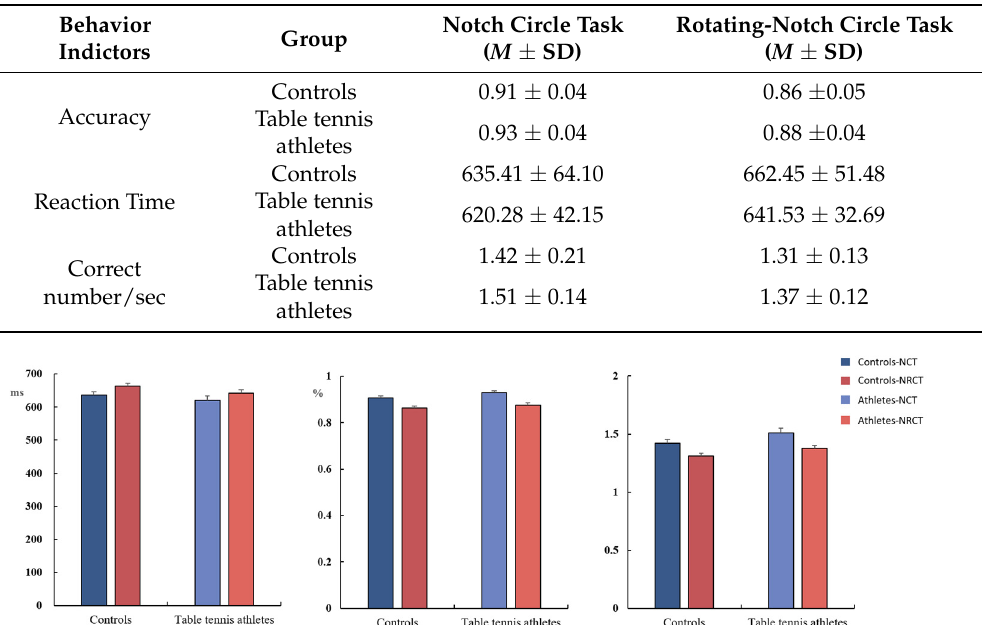
Table 2. Behavioral performance (mean ± standard deviation) in the two types of tasks in the control and table tennis groups.